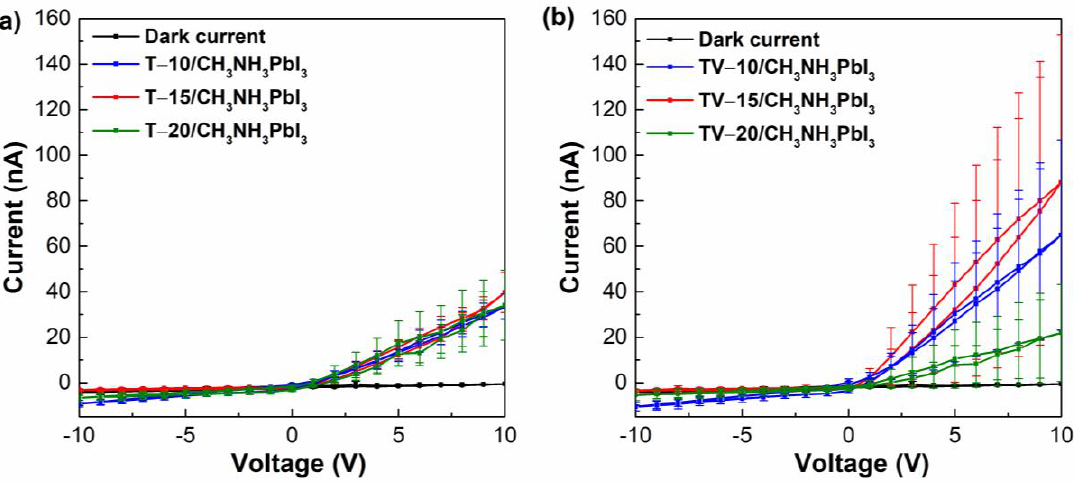
Figure 7. Photocurrent characteristic of heterojunctions of TiO 2 nanotubes and CH 3 NH 3 PbI 3 single crystals. ( a ) TiO 2 nanotubes without deposition of vanadium oxide and ( b ) nanotubes with deposition of vanadium oxide